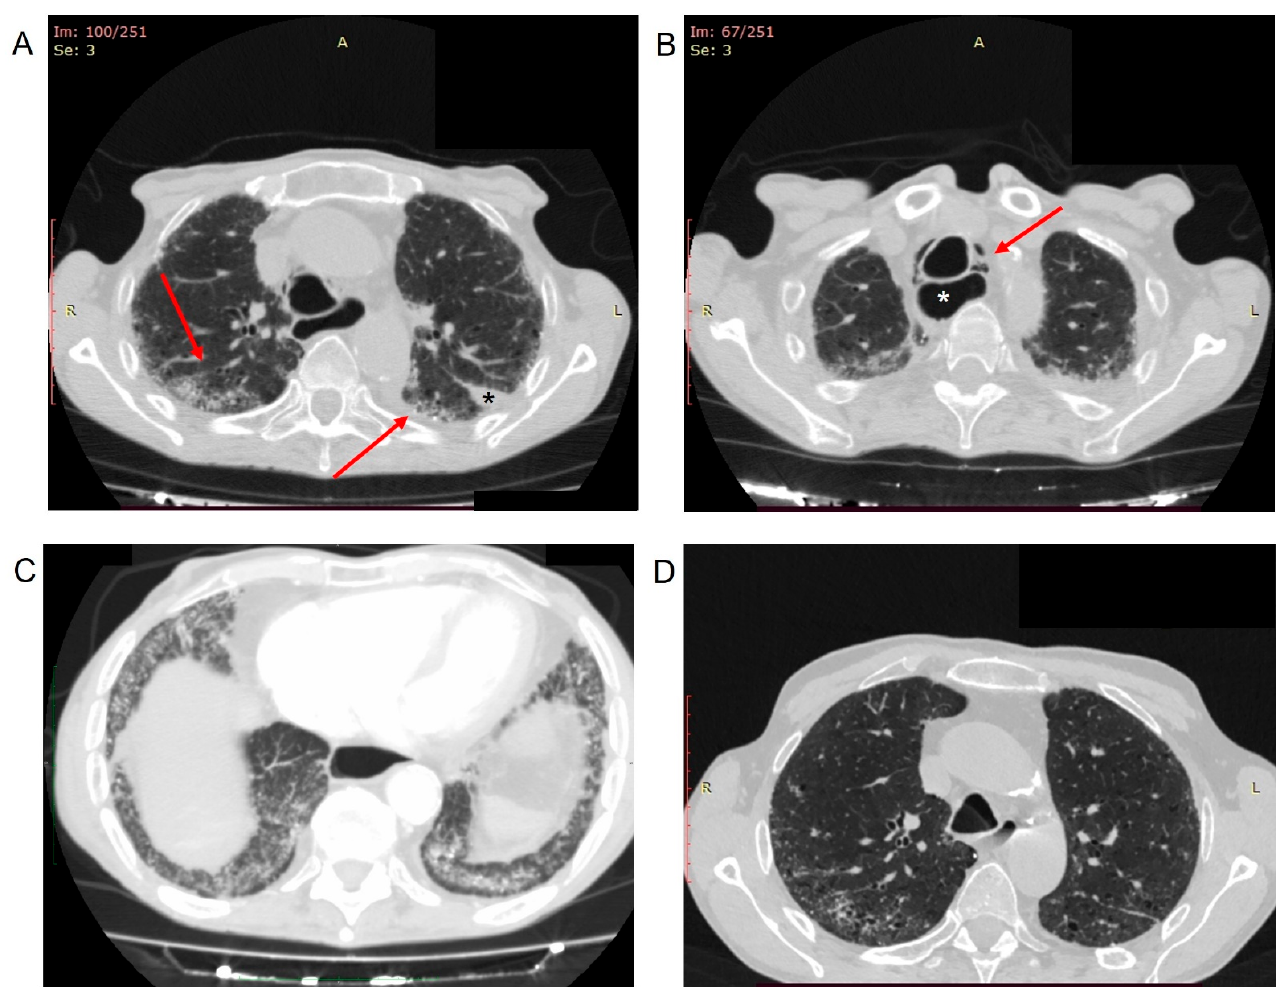
Figure 1. ( A – D ) Post-COVID-19 computed tomography (CT) pulmonary angiography. ( A ) Diffuse fibrotic changes with subpleural ground-glass opacity ( arrows ), traction bronchiectasis, and several emphysematous bullae were evident. Mild pleural effusion in the left oblique fissure ( black asterisk ) and mild left-sided paravertebral pleural effusion. ( B ) Pneumo-mediastinum ( arrow ) with enlarge- ment of the esophagus ( white asterisk ). ( C ) Mild ground-glass opacification in both lower lobes with sparing of subpleural regions. ( D ) CT-Scan of the thorax performed two months before the COVID-19, showing peripheral interstitial thickening and traction bronchiectasis due to the systemic sclerosis interstitial lung disease.